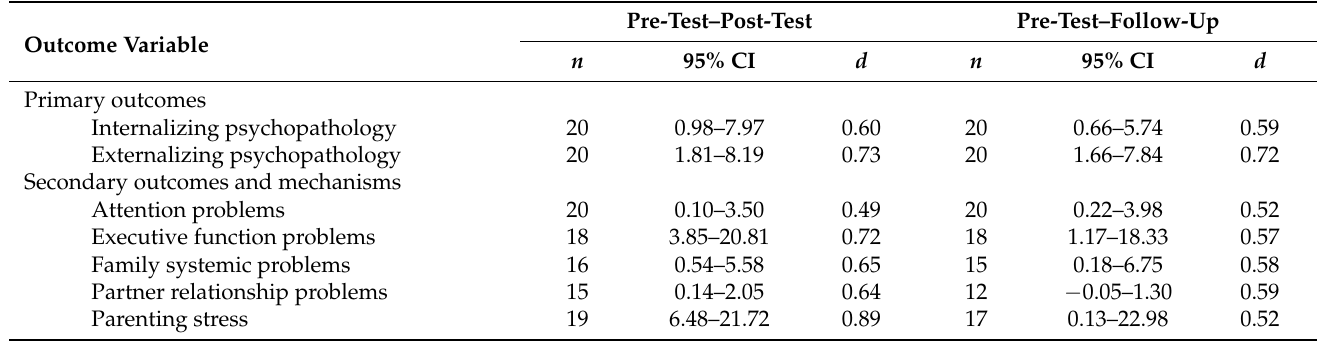
Table 3. Confidence intervals and effect sizes of change between pre-test and post-test and between pre-test and